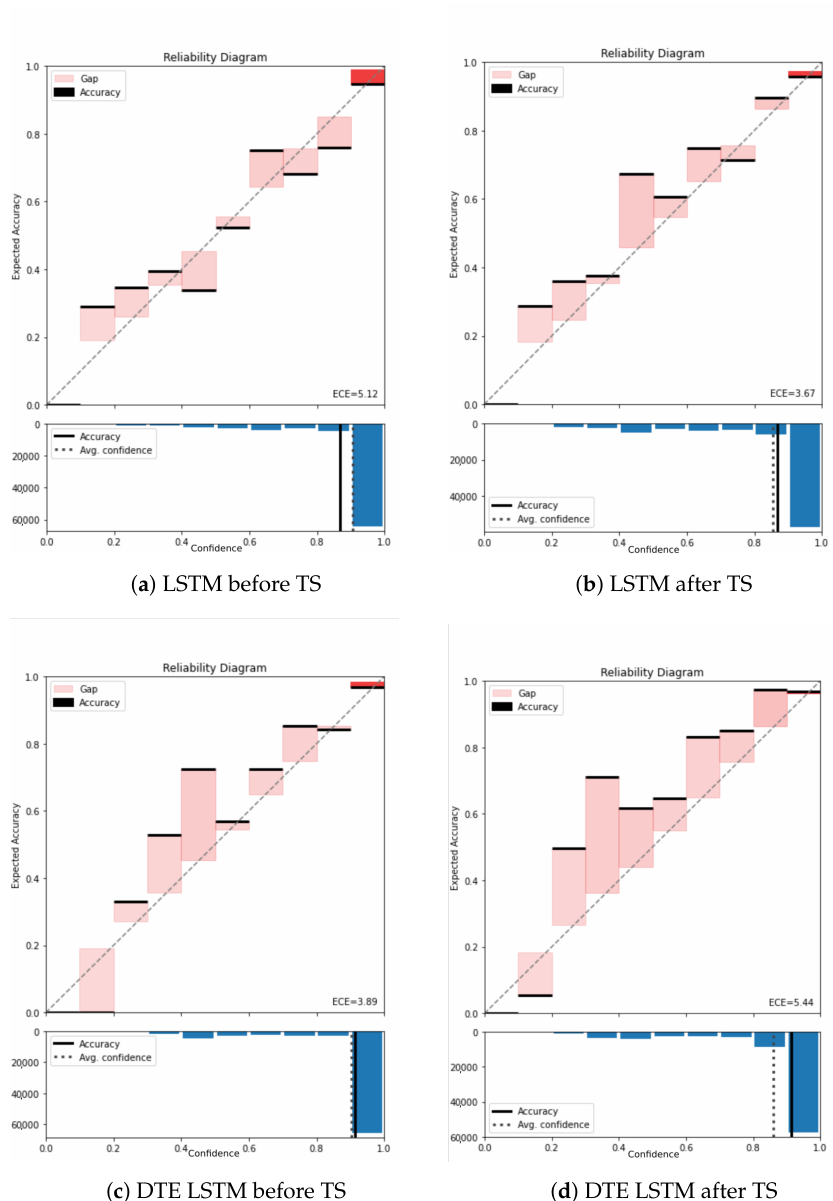
Figure A5. Reliability diagram of PAMAP2 with and without temperature scaling for LSTM and DTE LSTM